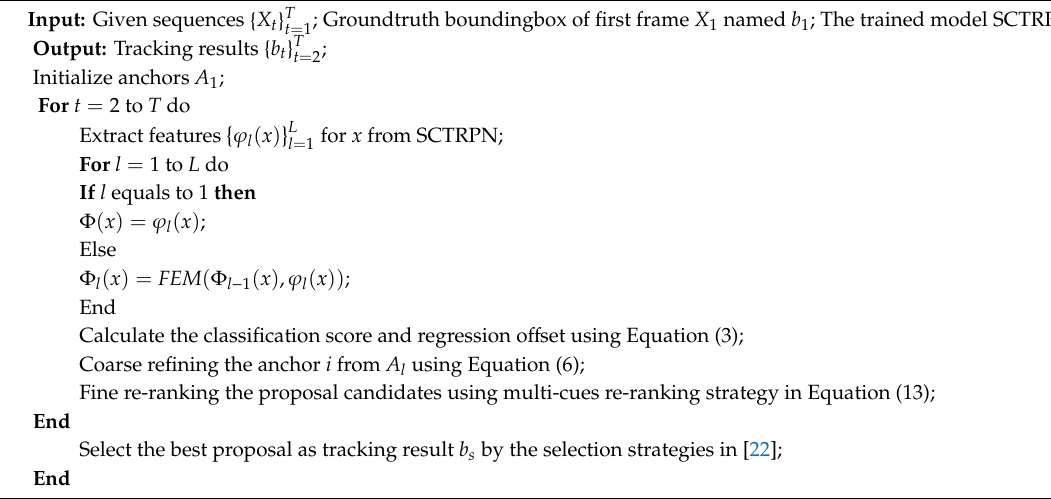
Algorithm 1 Proposed Tracking